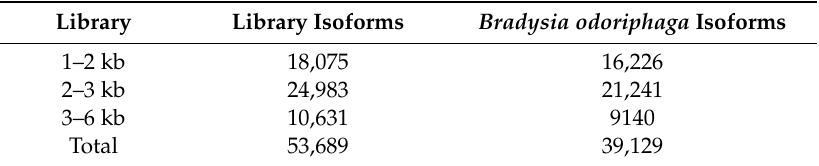
Table 3. Number of